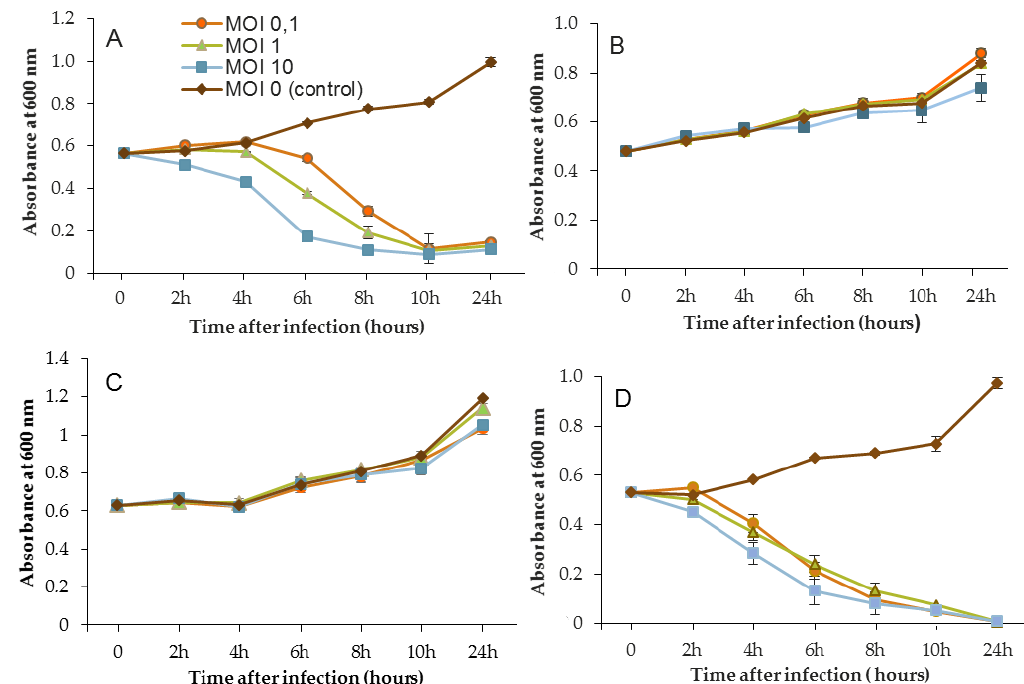
Figure 3. Activity of the phage LUZ7 against planktonic cells of four different P. aeruginosa strains ( A ) D1, ( B ) MLM, ( C ) ST395E, ( D ) PAO1. Each experiment was performed in triplicate, and bars indicate standard deviations. Multiplicity of infection (MOI).